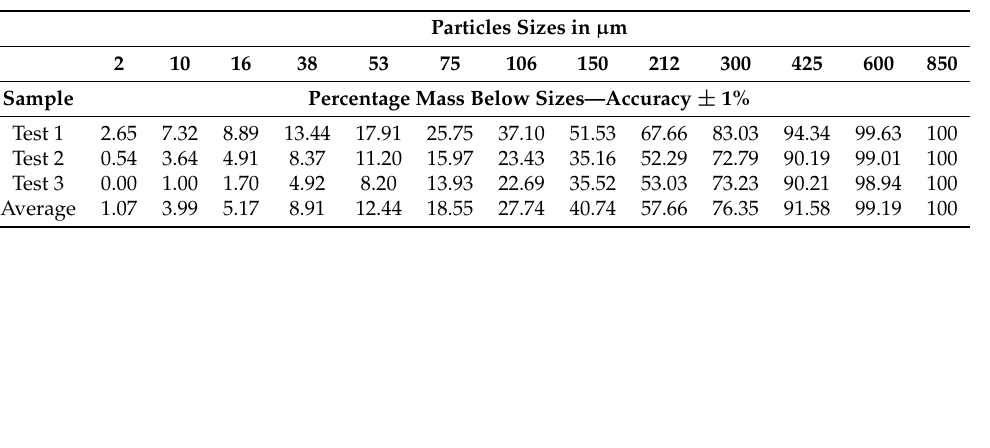
Table 2. Feed particle size distribution—cumulative